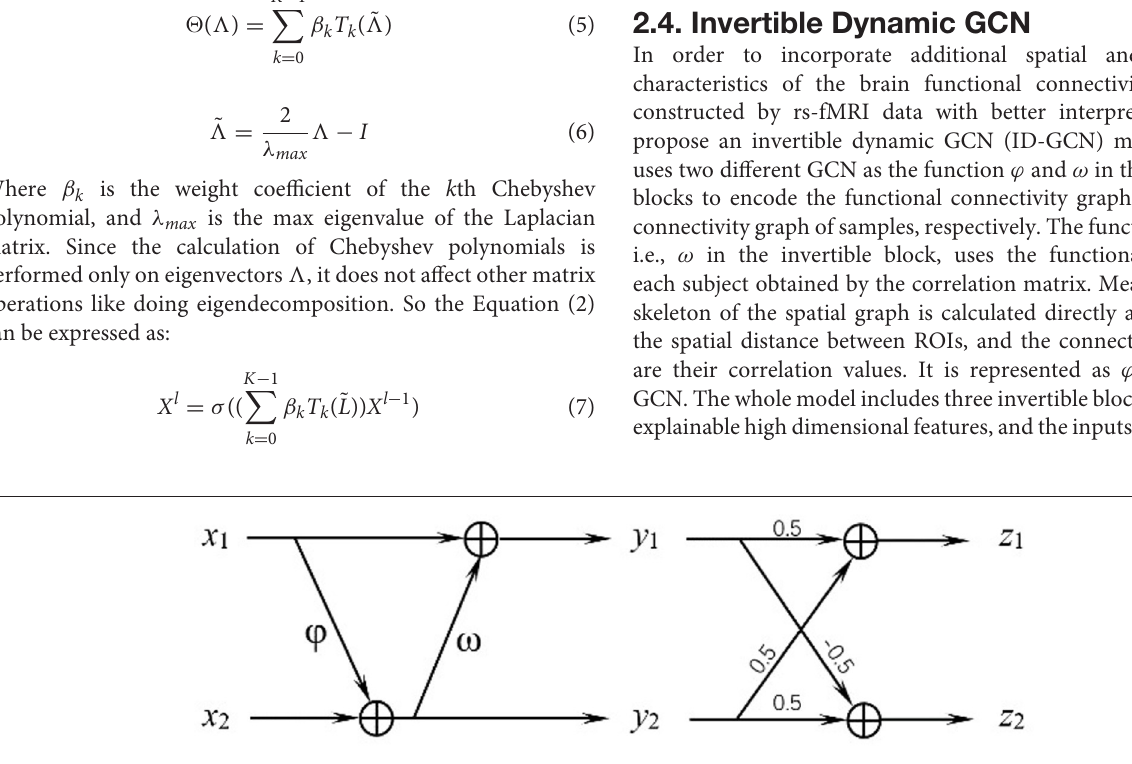
FIGURE 1 | Structure of the invertible